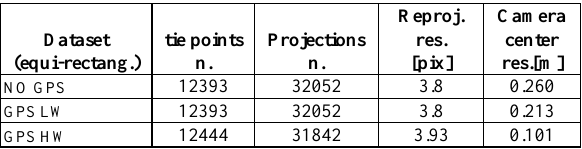
Table 12. Equirectangular dataset: stats on collinearity residuals.